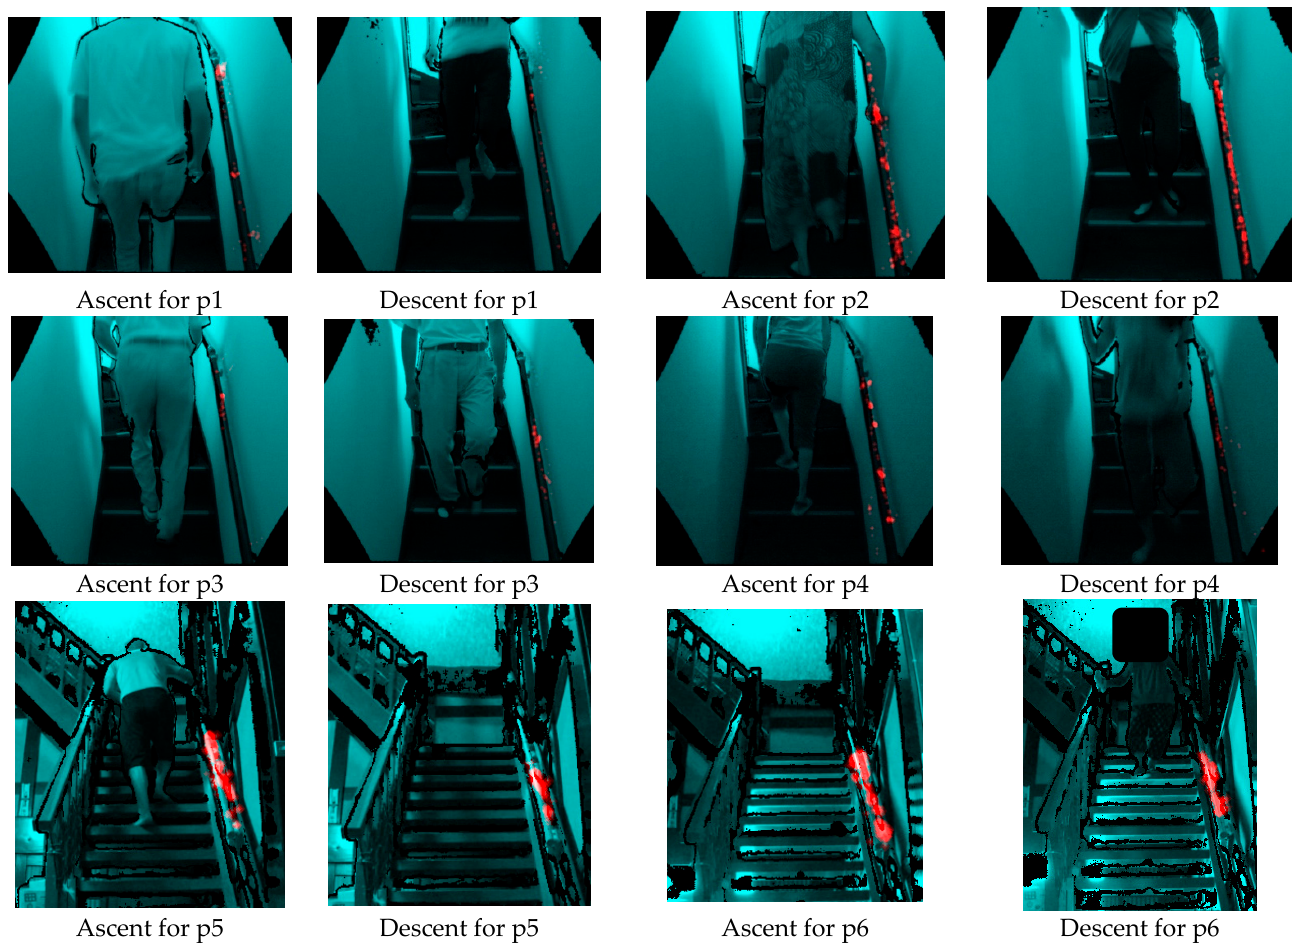
Figure 8. Heat map of the grasping points. Red color indicates a more intense area where the participant grasped more frequently.